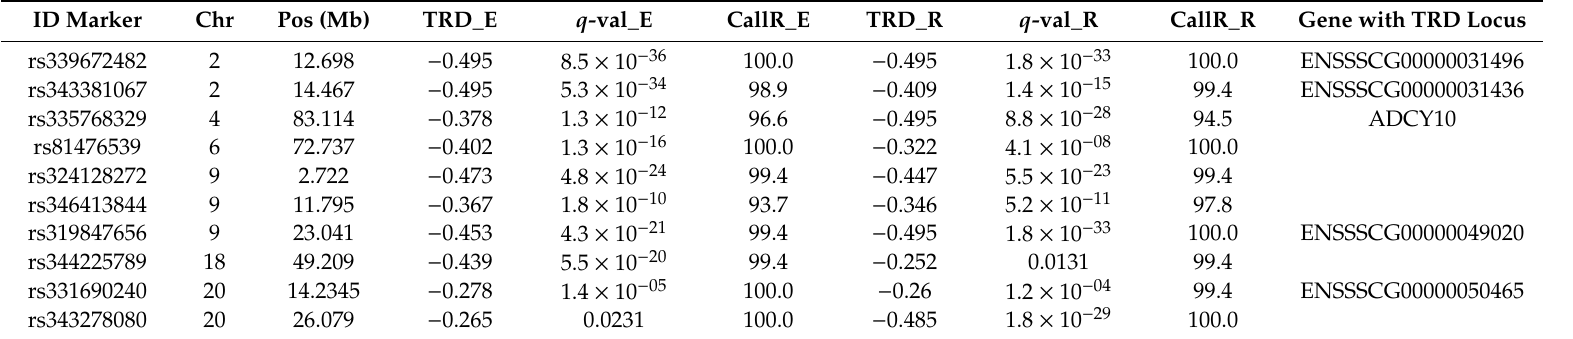
Table 1. Common maternal transmission ratio distortion loci (TRDLs) detected in both Iberian